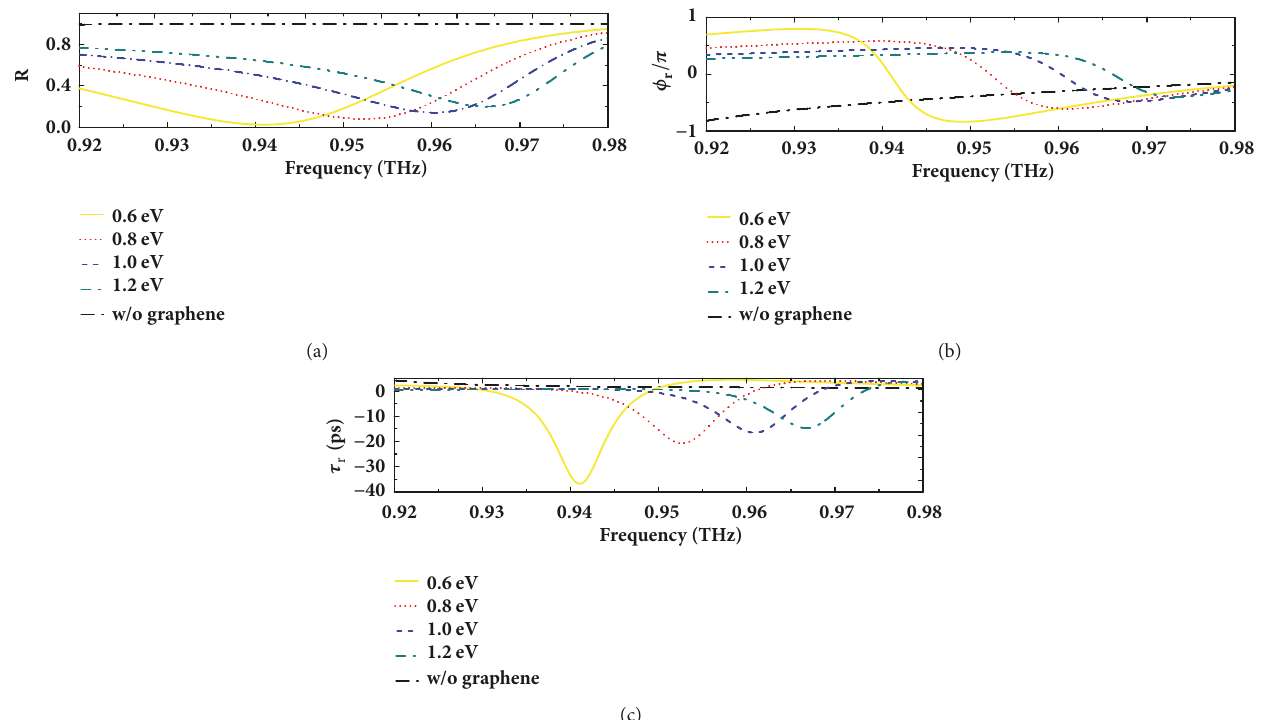
Figure 2: (a) Reflectance R, (b) reflected phase 𝜙 𝑟 , and (c) reflected group delay 𝜏 𝑟 as functions of frequency for different Fermi energies in the graphene-1D PC structure. For comparison, reflectance R, reflected phase 𝜙 𝑟 , and reflected group delay 𝜏 𝑟 without graphene is shown as well. Other parameters are the same as